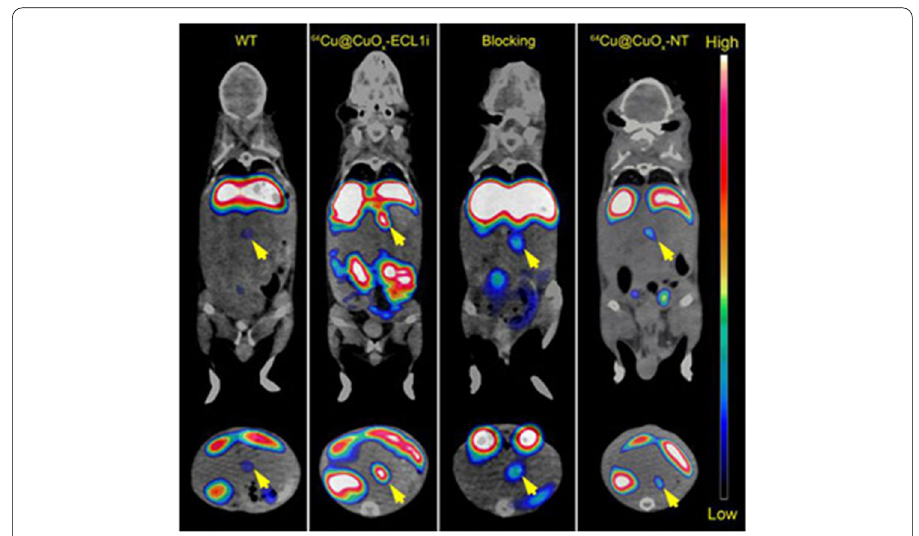
Fig. 4 Representative in vivo PET/CT images of [ 64 Cu]Cu@CuOx-ECL1i. Images of [ 64 Cu]Cu@CuOx-ECL1i in KPPC mice, KPPC mice with 50-fold blocking dose, and [ 64 Cu]Cu@CuOx-NT in KPPC mice were performed at 24 h post injection (yellow arrow: pancreas/pancreatic tumor). Reprinted (adapted) with permission from X. Zang et al. ACS Nano 2021 (Zhang et al. 2021). Copyright © 2021 American Chemical